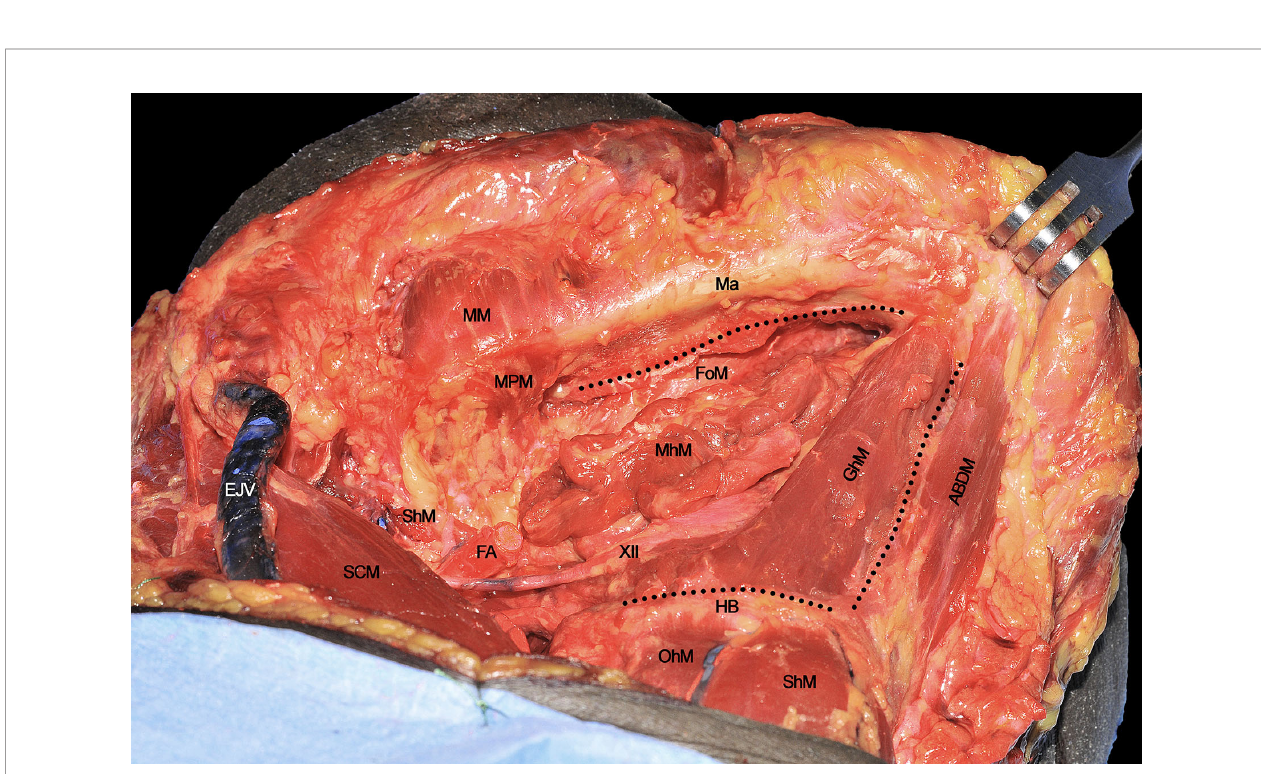
ShM, sternohyoid muscle; StM, stylohyoid muscle; XII, hypoglossal nerve. Black dotted line, boundaries of the anatomical area containing the T-N